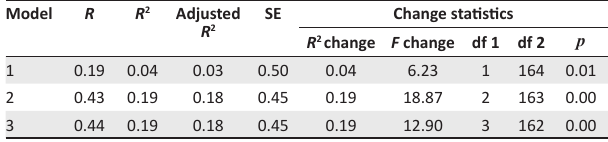
TABLE 5: Regression summary for APP and SC (Model 1) + TC (Model 2) + SC × TC (Model 3).